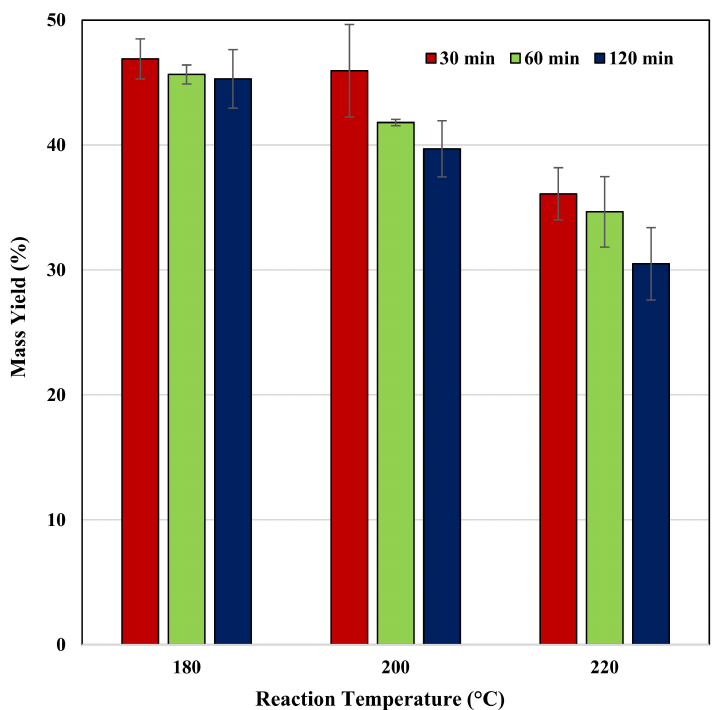
Figure 4. Effect of the reaction temperature on the mass yield of the hydrochar in